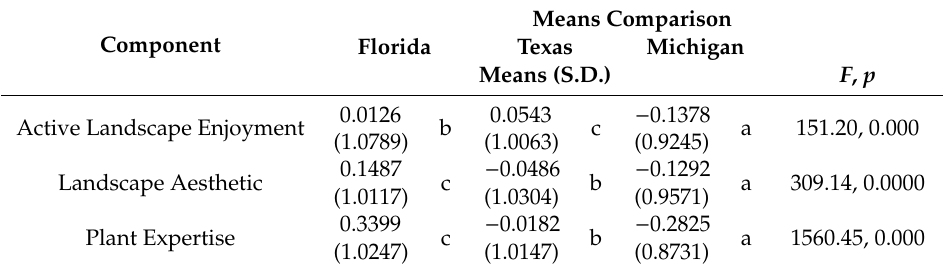
Table 5. Mean comparisons of the principal components by state 1